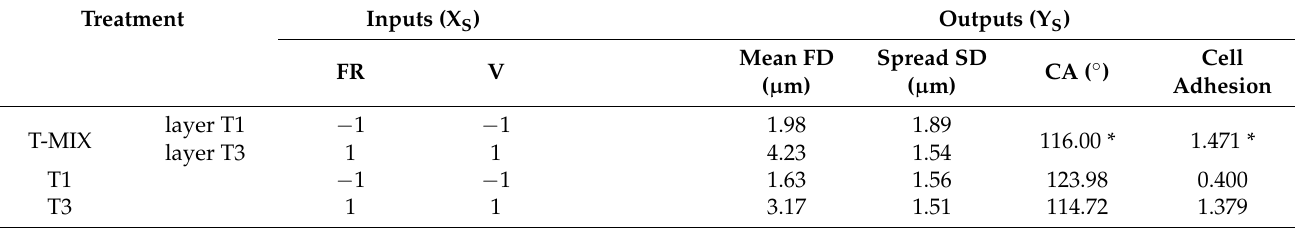
Table 9. Input and output data of the samples T-MIX, T1, and T3, to directly compare the by-layer system vs the parent scaffolds. All T1, T3, and T-MIX were electrospun for 10 min with “layer T1” and “layer